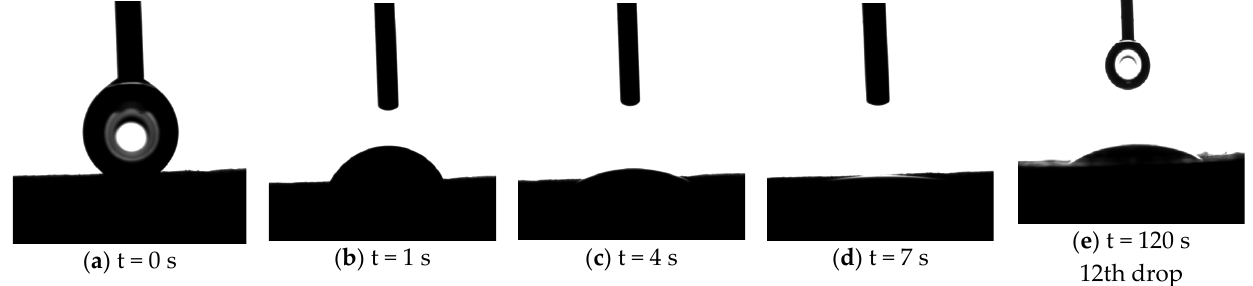
Figure 10. Water contact angles of leather coated by composite xerogels at different time intervals.